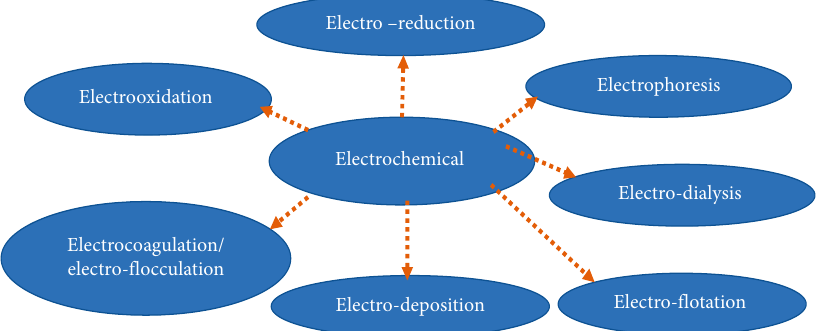
Figure 1: Types of electrochemical